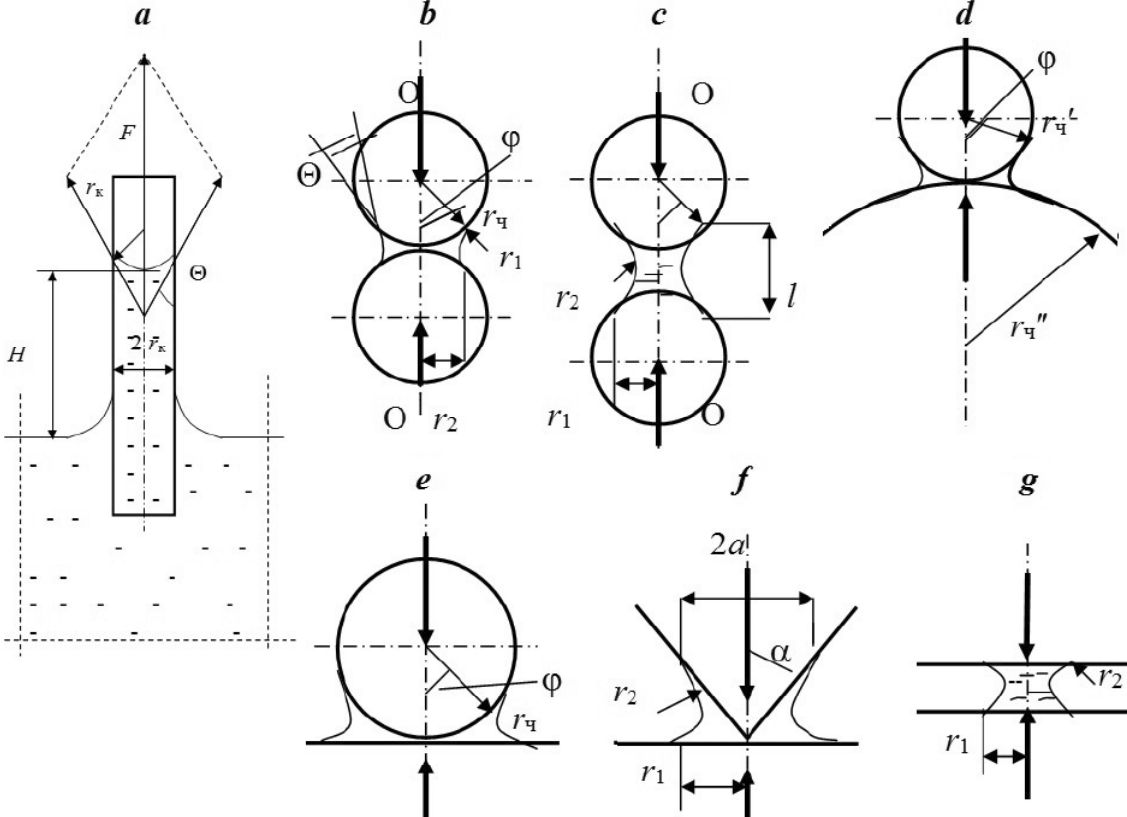
Fig. 3. Capillary raising liquid in the tube and forces of capillary cohesion between two